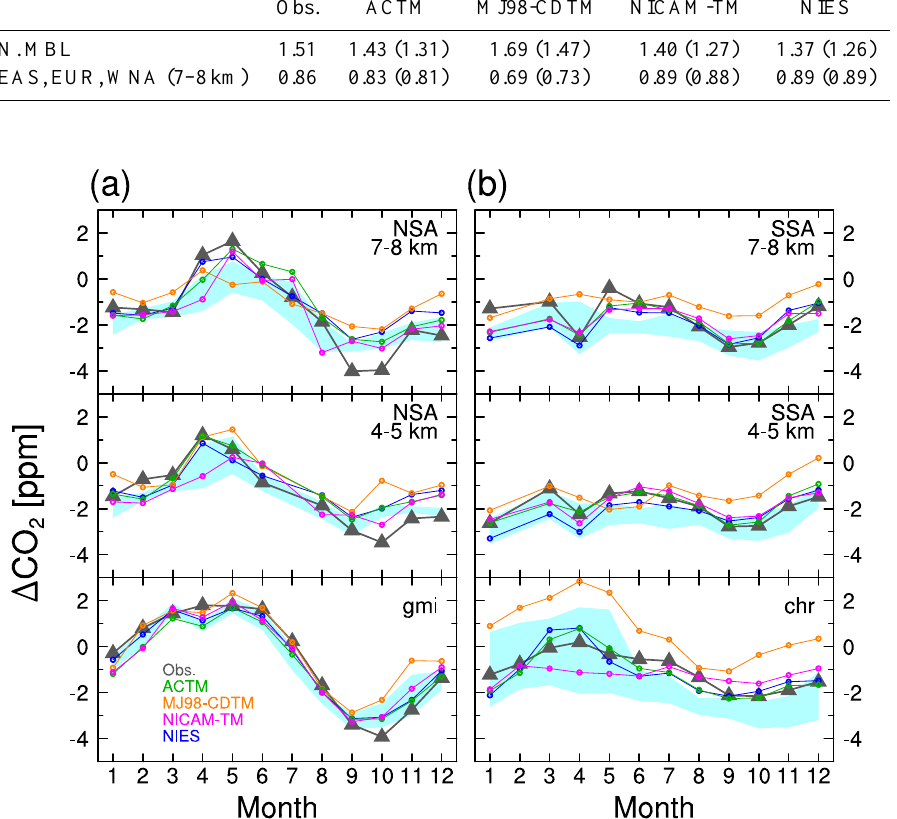
Fig. 8. Monthly mean variations of 1 CO 2 over the Southeast Asia areas (NSA and SSA) at two altitude ranges (top two panels), and at two MBL sites in NSA and SSA latitude bands (gmi, chr) for 2007. Gray triangles with lines show data derived from CON- TRAIL/GLOBALVIEW. The symbol/line and shaded area convention are same as Fig.